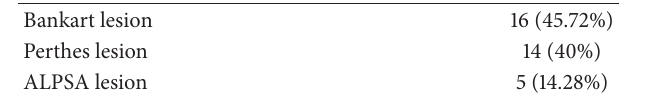
Table 1: Distribution of lesions underlying shoulder instability, as diagnosed by MRA.